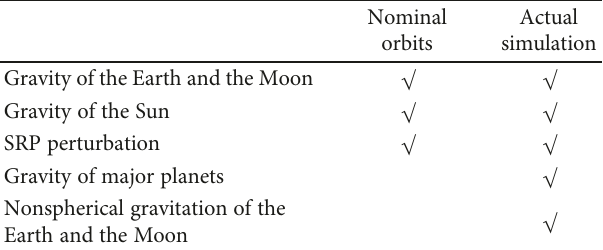
Table 1: Contrast of dynamic